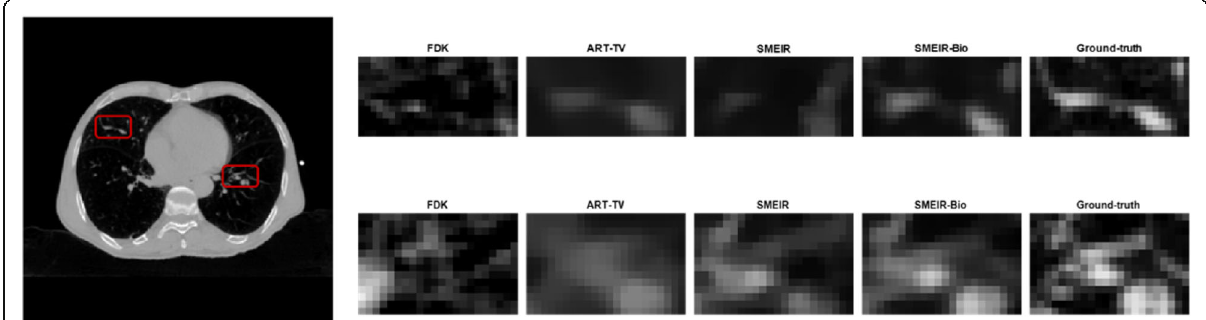
Fig. 5 Comparison between the fine details in the CBCT images reconstructed by the FDK, ART-TV, SMEIR and SMEIR-Bio techniques, by using the “ Ground-truth ” 4D-CT reference phase image for evaluation. All CBCT reconstructions used 40 projections per phase, which were simulated from the “ Ground-truth ” images. FDK: Feldkamp-Davis-Kress; ART-TV: Algebraic reconstruction technique with total variation-regularization; SMEIR: